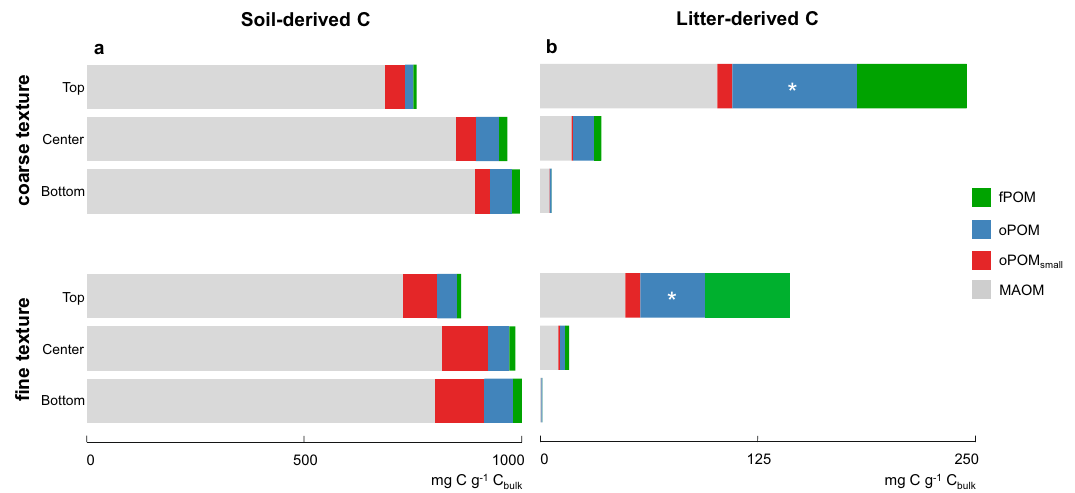
Fig. 2 Allocation of soil-derived and litter-derived C to OM fractions. Content of free particulate organic matter (fPOM), occluded POM (oPOM, oPOM small ), and mineral-associated OM (MAOM) in mg C g − 1 C bulk of ( a ) soil and ( b ) litter origin in three depths of coarse-textured and fi ne-textured soil (means, n = 3 independent replicates). Asterisks represent signi fi cant differences between the textures (* P = 0.007). Statistical signi fi cance was analyzed using an unpaired two-sided t -test.